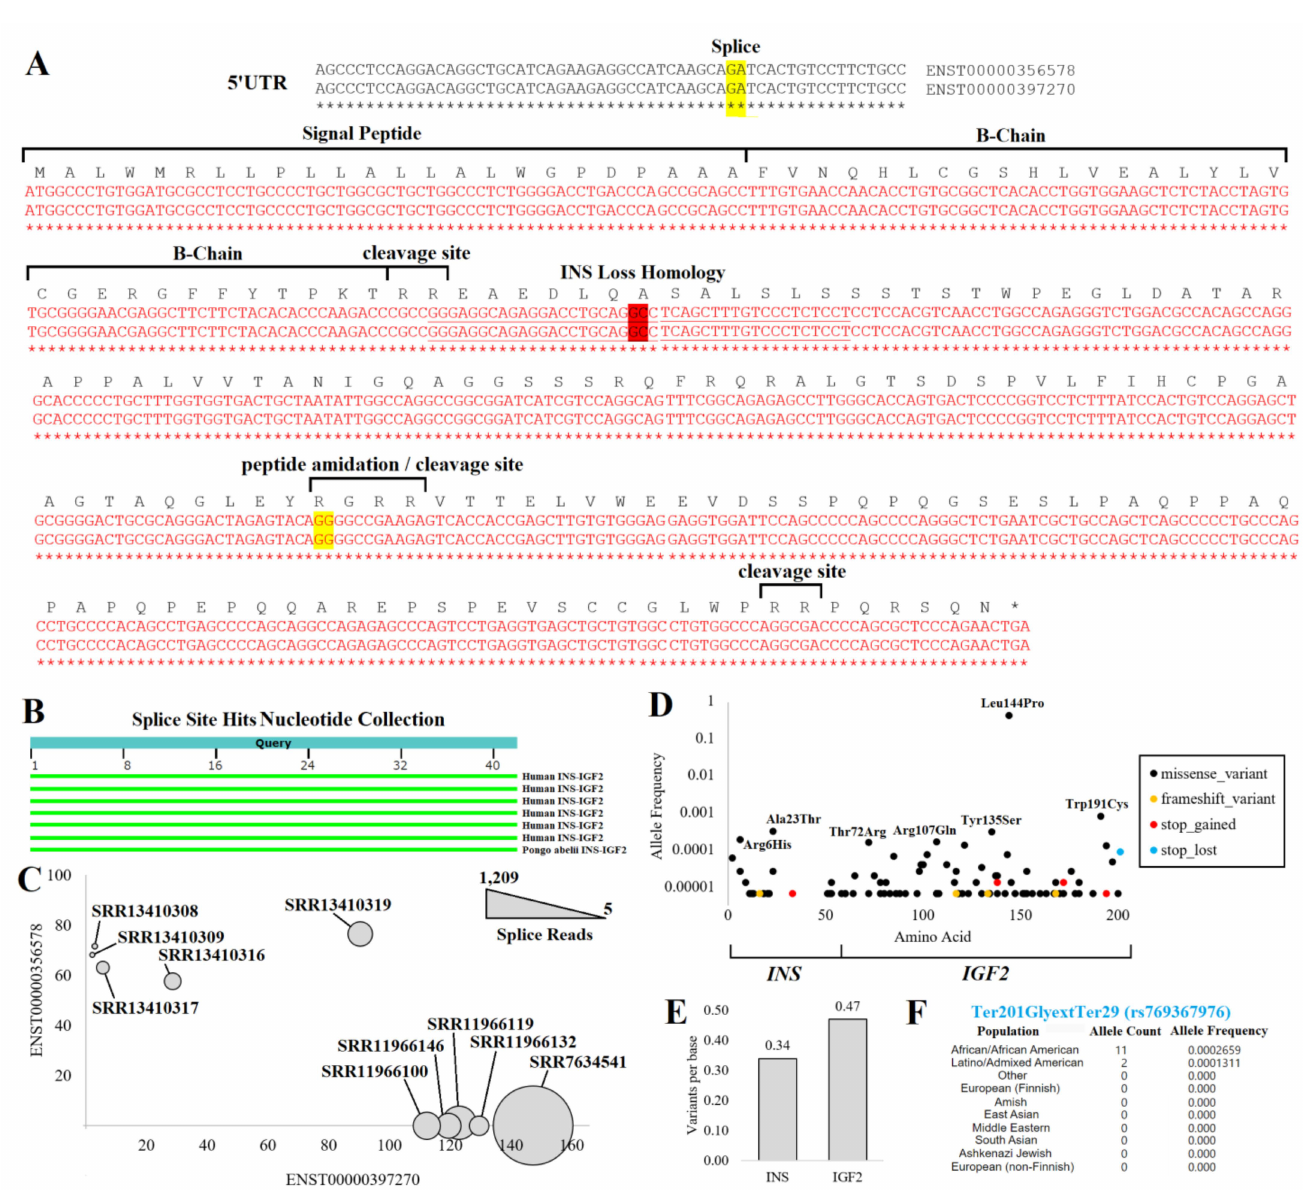
Figure 10. INS–IGF2 protein insights. ( A ) Nucleotide to amino acid alignment for the two INS–IGF2 transcripts. Splice sites are highlighted in yellow, with the fusion splice site highlighted in red. The underlined sequence was used for the unique detection of fusion splicing. The nucleotide sequence on top is from ENST00000356578. and the bottom is from ENST00000397270. The INS Loss Homology site is where the INS–IGF2 diverges from INS sequence. ( B ) Nucleotide collection BLAST hits of the underlined sequence for unique fusion splicing. ( C ) SRA BLAST hits of fusion splice sites (bubble size) for ten RNAseq samples relative to Salmon-based annotations of each INS–IGF2 transcript. ( D ) The gnomAD version 3 variants of the fusion transcript show the allele frequency (y-axis) relative to the amino acid location (x-axis) for variants that influence the protein. ( E ) The probability of unique variants per base found within the protein’s INS or the IGF2 region. ( F ) Allele frequencies from various populations for the INS–IGF2 loss of stop codon